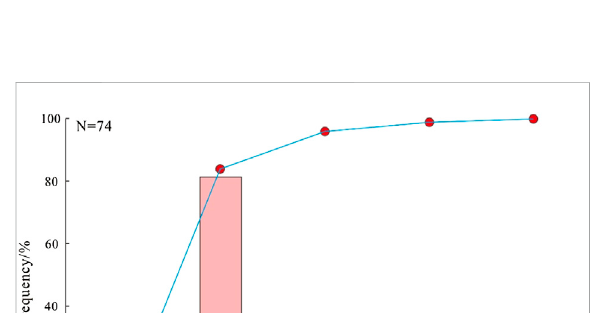
FIGURE 4 Crossplotofporosity andpermeabilityofdifferentlithologies of the Carboniferous system in the Shixi Oil fi eld.